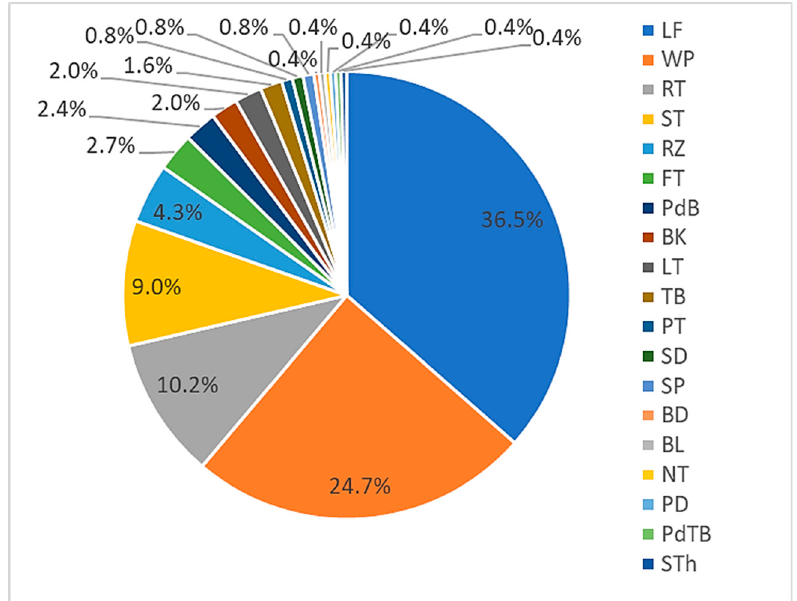
Figure 4. Components of epiphytic plants used in medicinal preparations (represented in